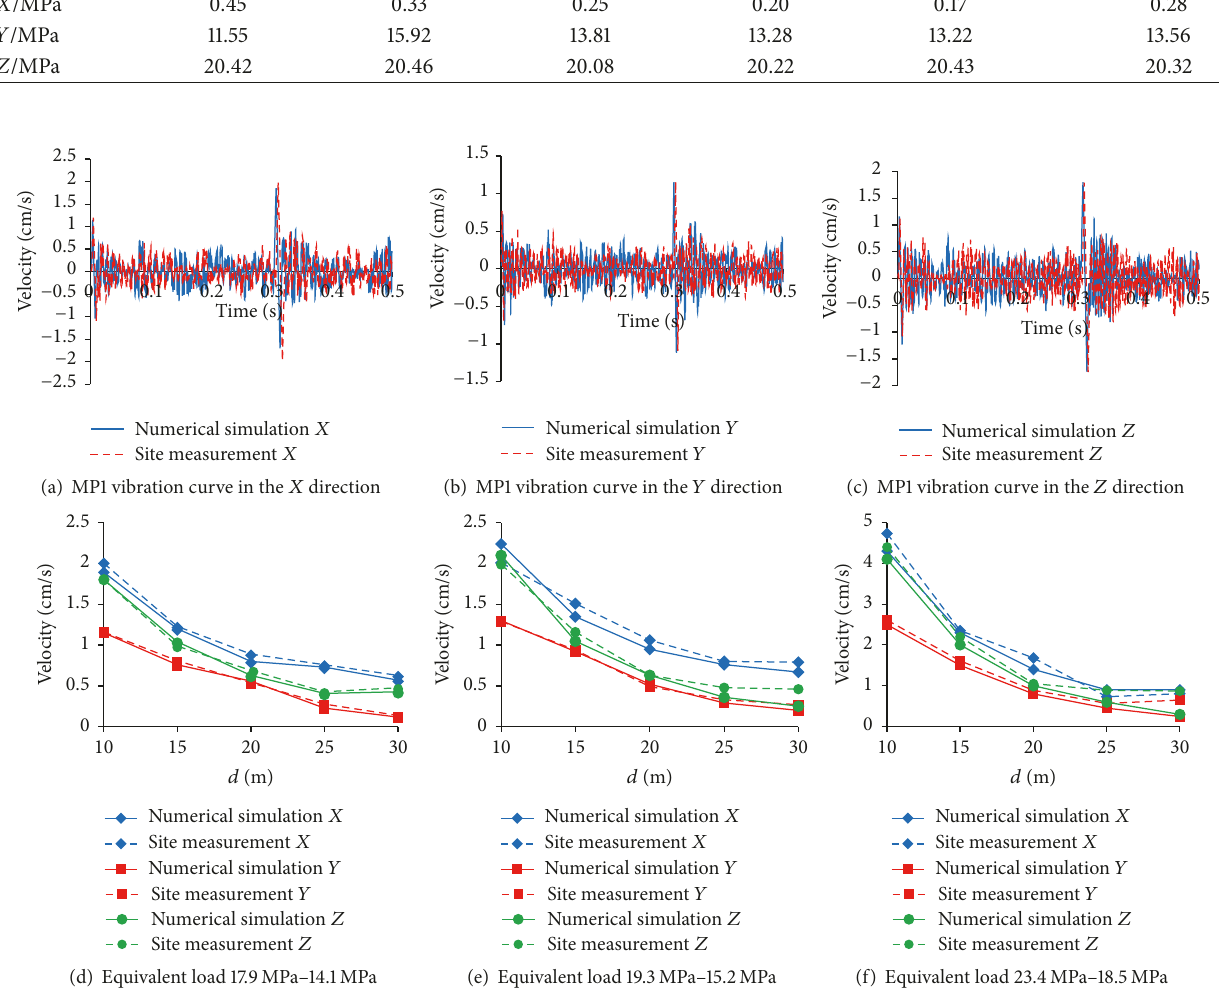
Figure 11: The comparison of vibration velocity of measuring points in numerical simulation and field